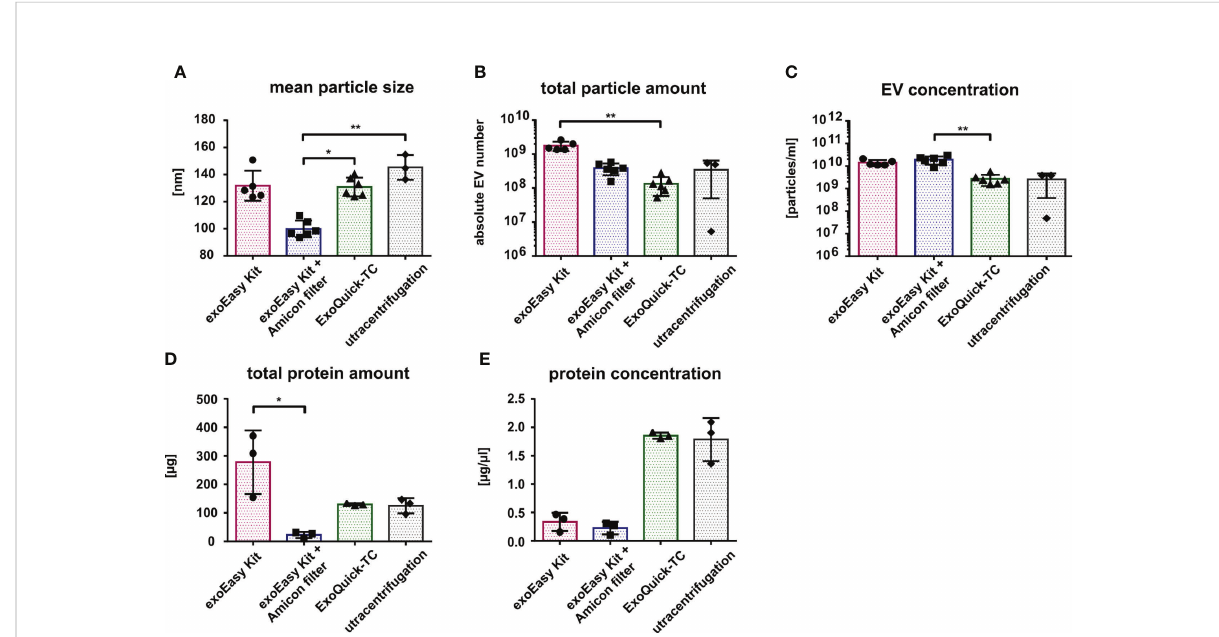
FIGURE 4 Characterization of primary AML-derived EVs according to different isolation methods. Nanoparticle tracking analysis of size (A) , total particle number (B) , and EV concentration (C) from primary AML-cell-derived EVs isolated by different isolation methods (n = 5 for exoEasy Kit, n = 6 for exoEasy Kit with fi lter units and ExoQuick-TC, and n = 3 for UC). Measurement of the total protein amount (D) and protein concentration (E) from primary AML EVs with different isolation methods (n = 3). * p <0.05, ** p